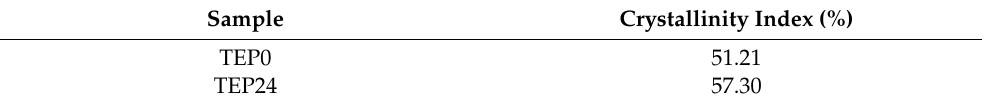
Table 1. Crystallinity index (CI) of TEP0 and